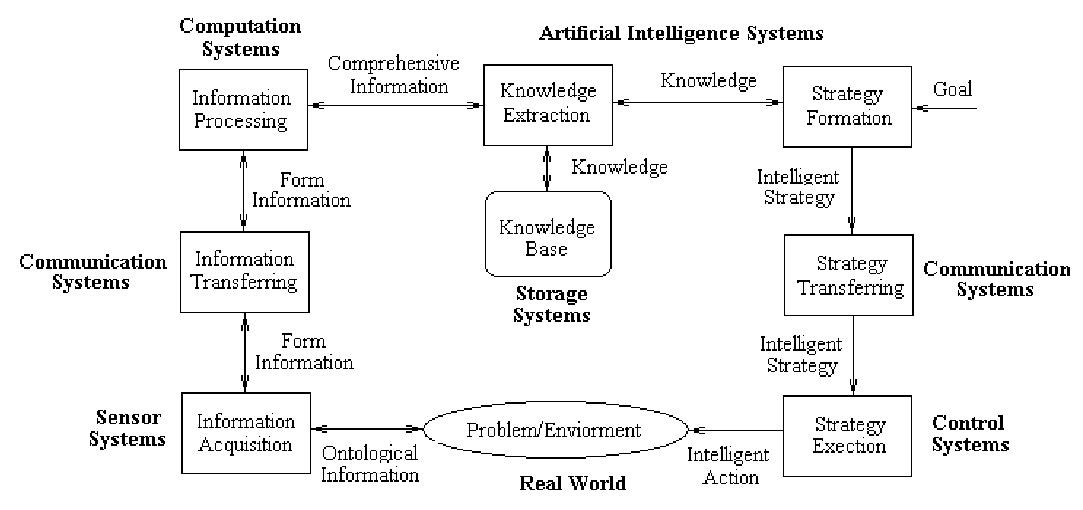
Figure 1. Conceptualized Model of Information